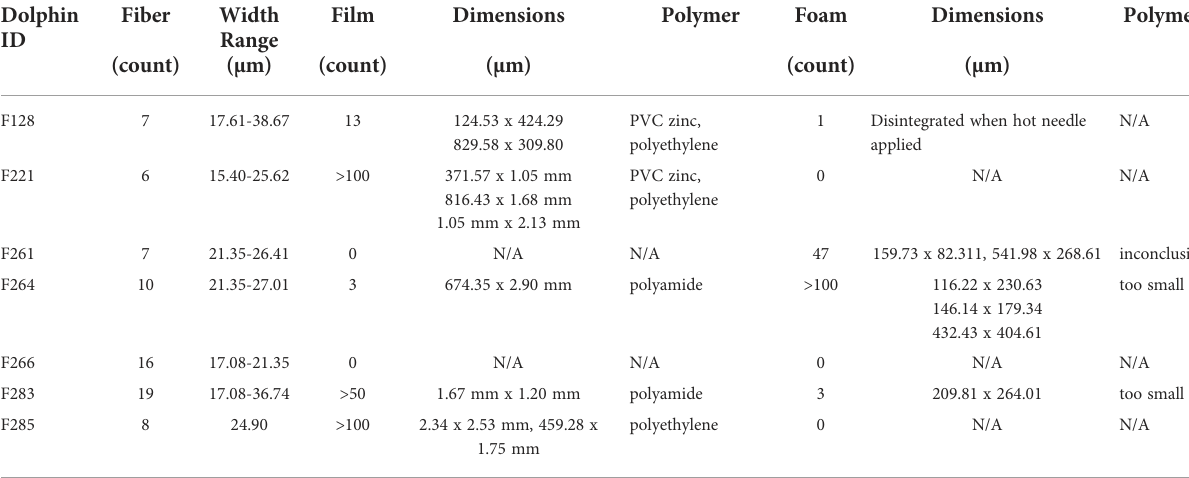
TABLE 4 Suspected Plastic Particle Counts, Dimensions, and Composition (determined via FTIR). Dolphin Fiber Width Film Dimensions Polymer Foam Dimensions ID Range